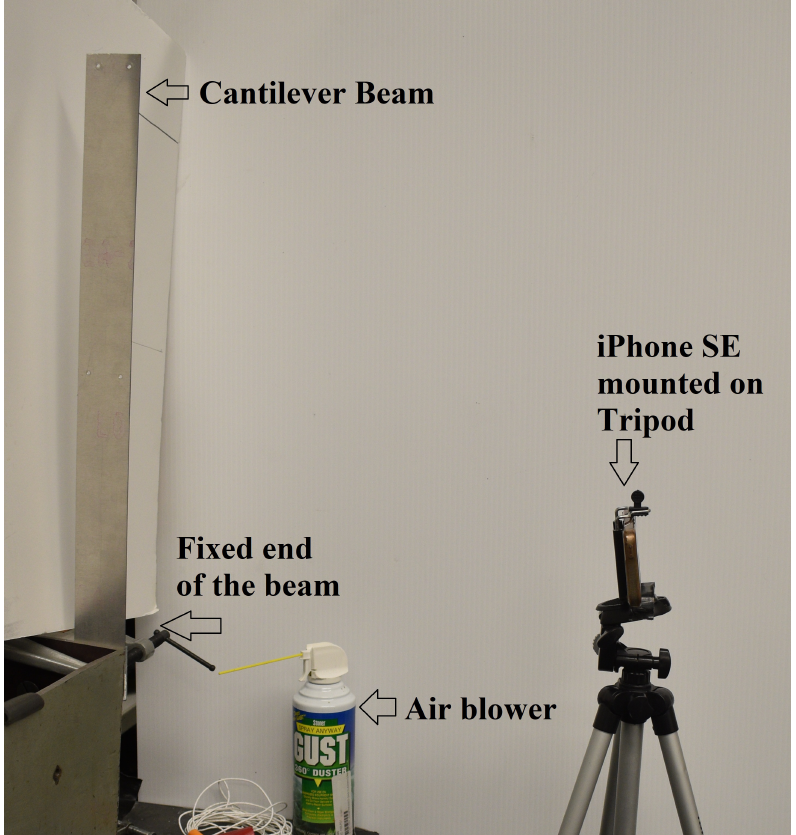
Figure 12. Experimental Set-up. An Aluminum beam is clamped at the table end, simulating the fixed end. This cantilever beam vibrates when an air blower blows the air on the beam. The iPhone SE records the beam vibration in slow-motion